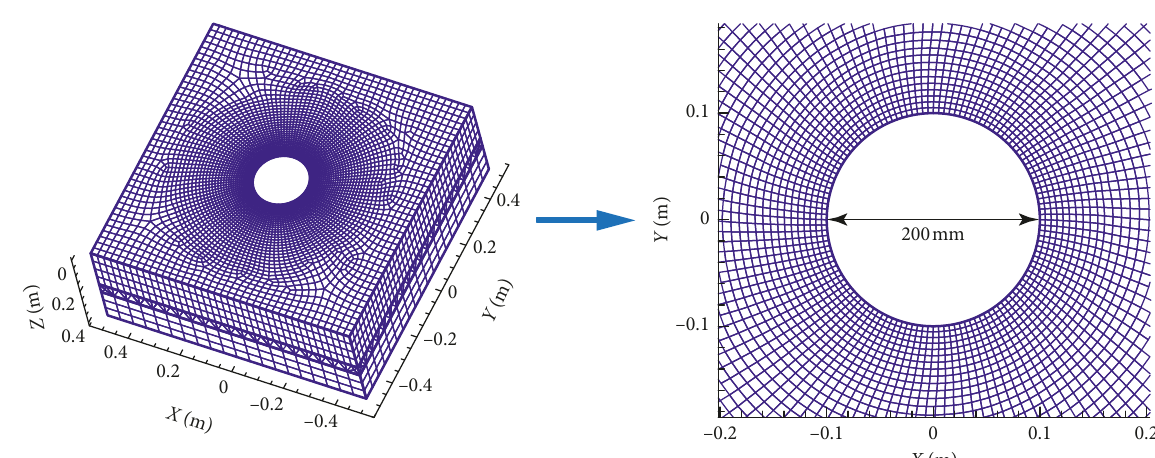
Figure 8: Numerical grid used to model the circular